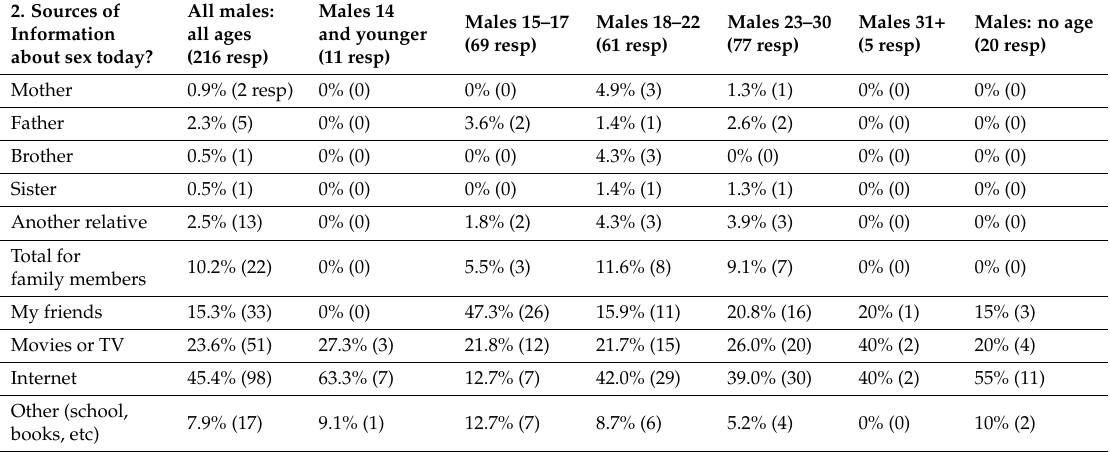
Table 3. Sources of Information about Sex—All